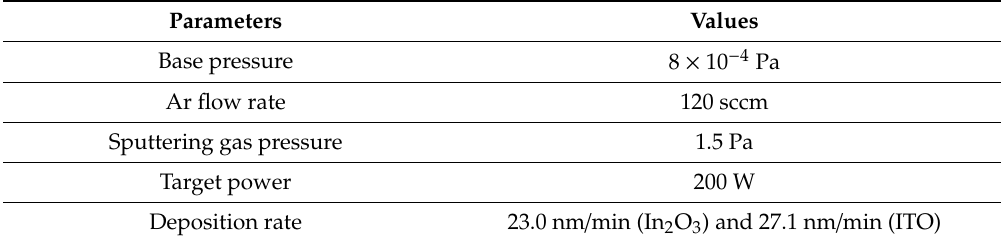
Table 1. Sputtering values used for the deposition of thin-film thermocouple legs and junctions.